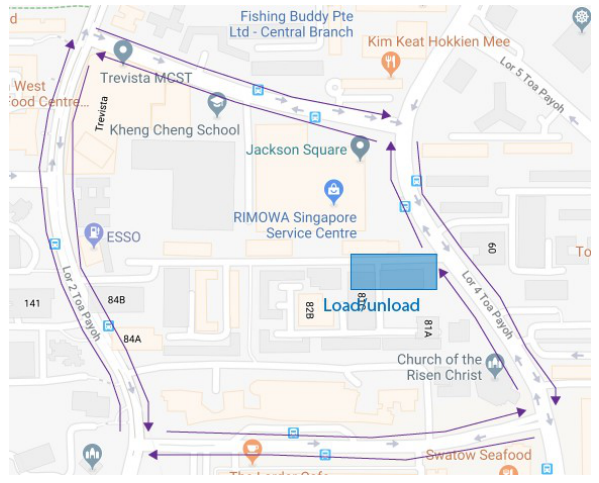
Figure 3. Toa Payoh scanning route.